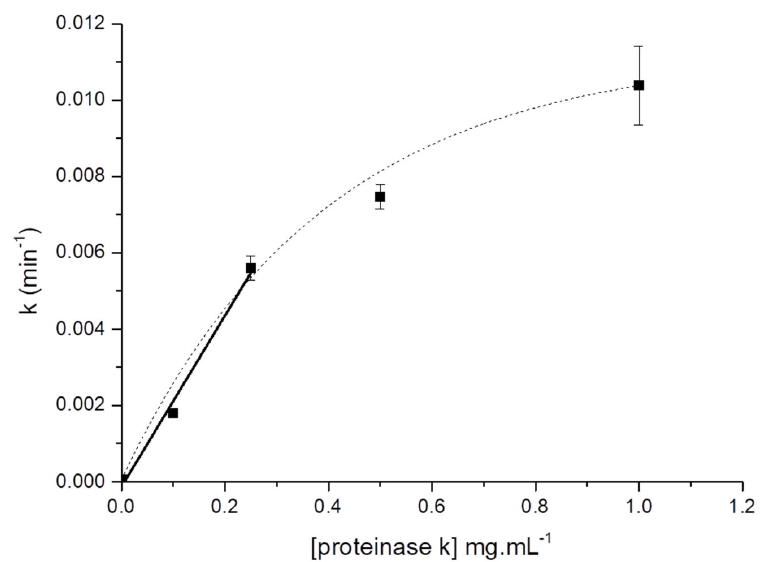
Figure 6. Plot of apparent rate constant ( k ) versus proteinase K concentrations (0.10, 0.25, 0.50 and 1.00 mg mL − 1 ). The values for k were obtained from linear fits in Figure 5; the error bars denote the standard error from these fits. The solid line corresponds to the linear least ‐ squares fit of the first three data points used to estimate the corresponding slope (0.022 mg mL − 1 min − 1 ) and serves, similar to the dotted line, as a guide to the eyes only.